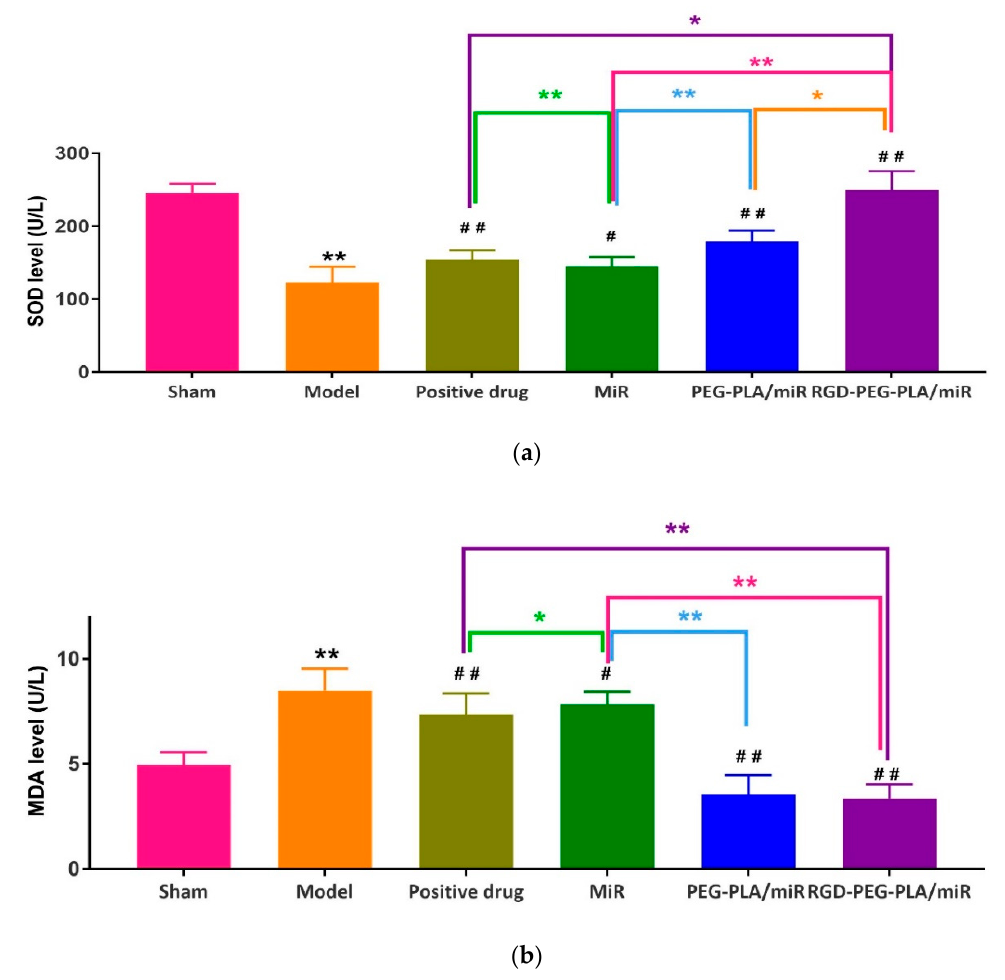
Figure 7. The levels of ( a ) creatine kinase isoenzyme (CK-MB), ( b ) lactic dehydrogenase (LDH), and ( c ) cardiac troponin T (cTnT) in six groups of rats (mean ± SD, n = 6). Compared with the sham